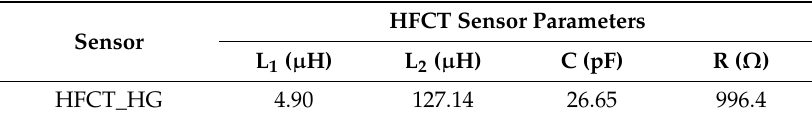
Table 2. HFCT_HG sensor parameters.